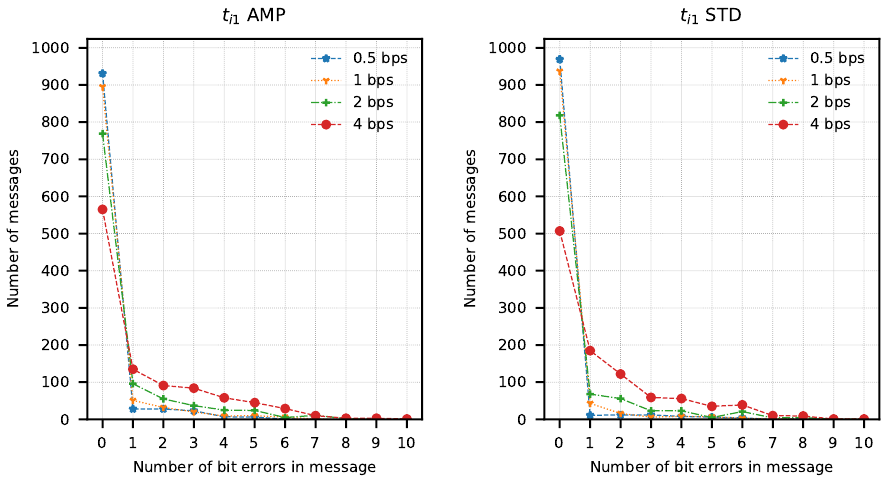
Figure 17. Number of bit errors in messages transmitted with t i 1 set calculated with amplitude analysis method (AMP) and amplitude variance analysis method (STD).